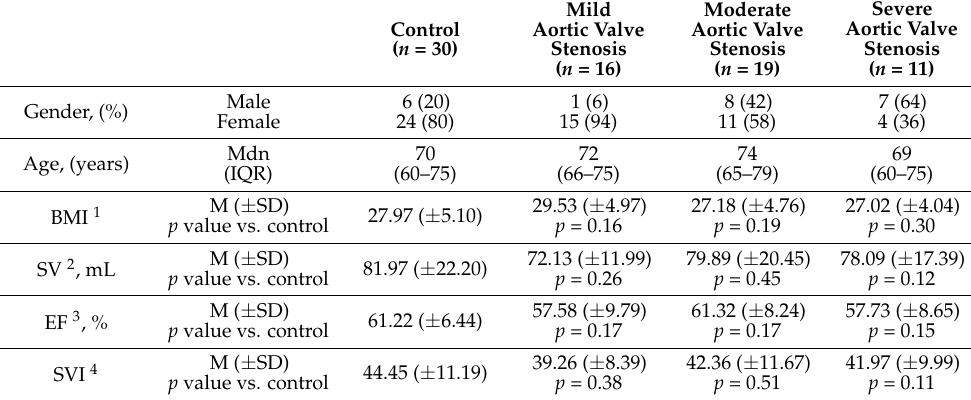
Table 1. Basic data of individuals in the control group and patients in the AS groups.